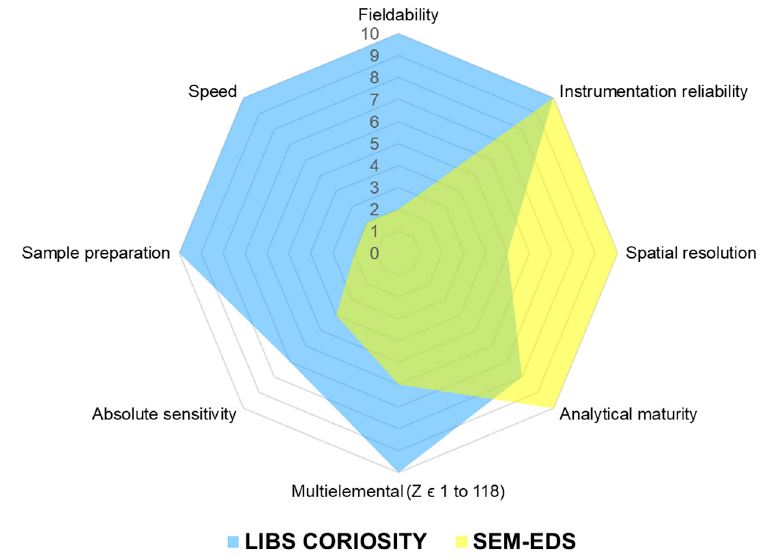
Figure 9. Radar plot of LIBS (blue) and SEM-EDS (yellow) parameters taken in consideration for this study.